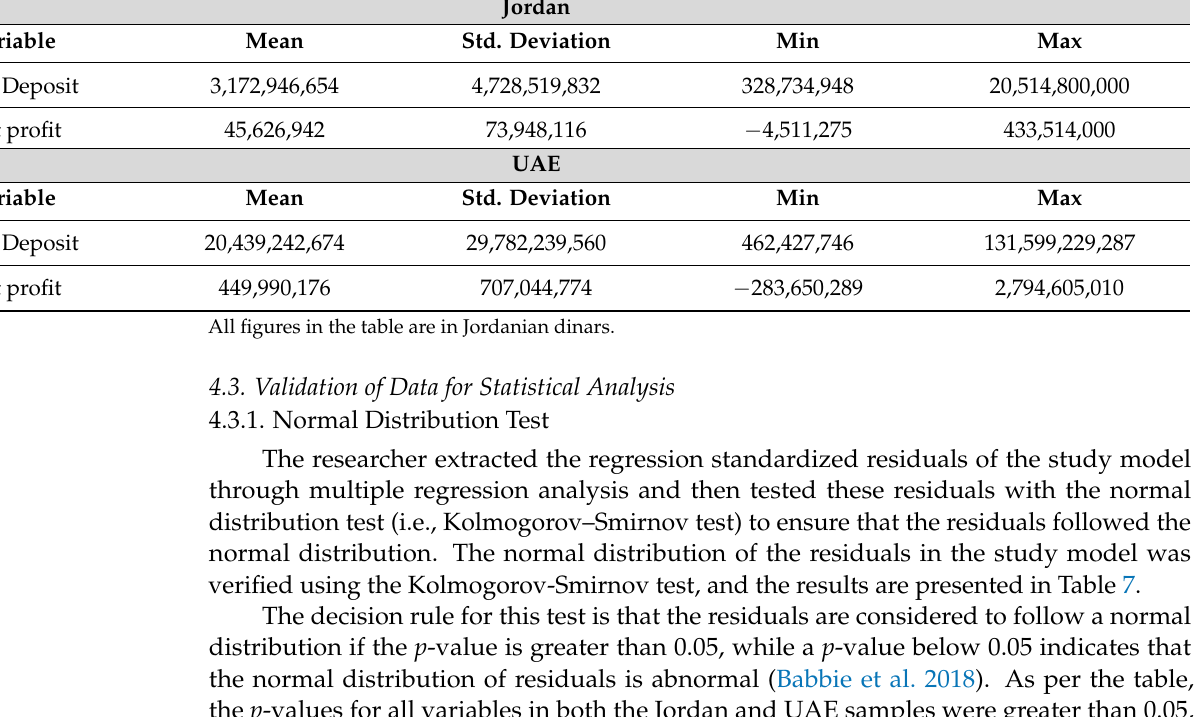
Table 6. Results of the Descriptive Analysis of the Dependent Variables.